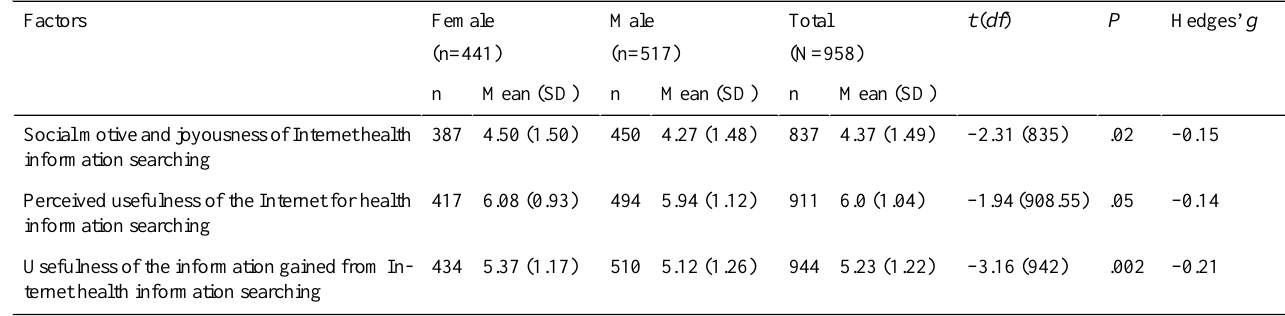
Table 3. Gender differences of weighted means of factor sum scores for motives influencing Internet health information searching on an aggregate level.